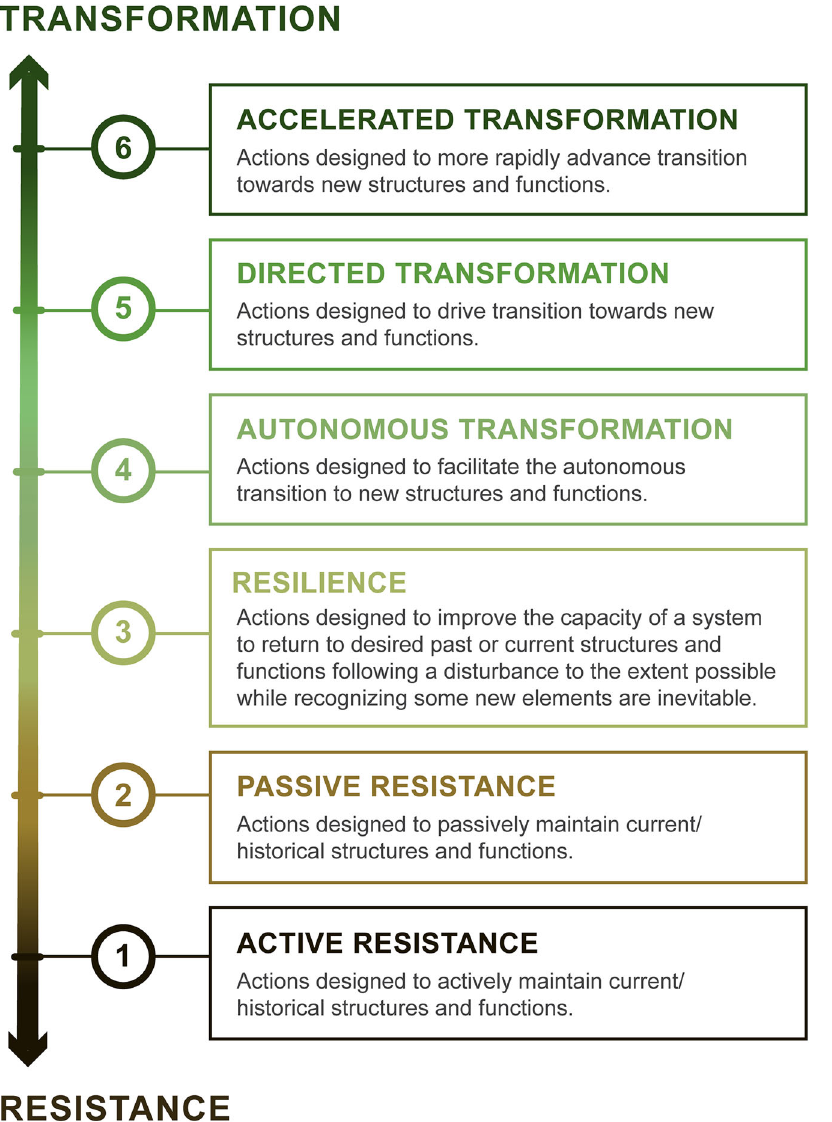
Fig. 1 Resistance – resilience – transformation (R – R – T) scale with de fi nitions. The R – R – T scale is a six-point continuous interval scale representing a continuum spanning from actively resisting changes to accelerating transformation towards new, more climate-adapted